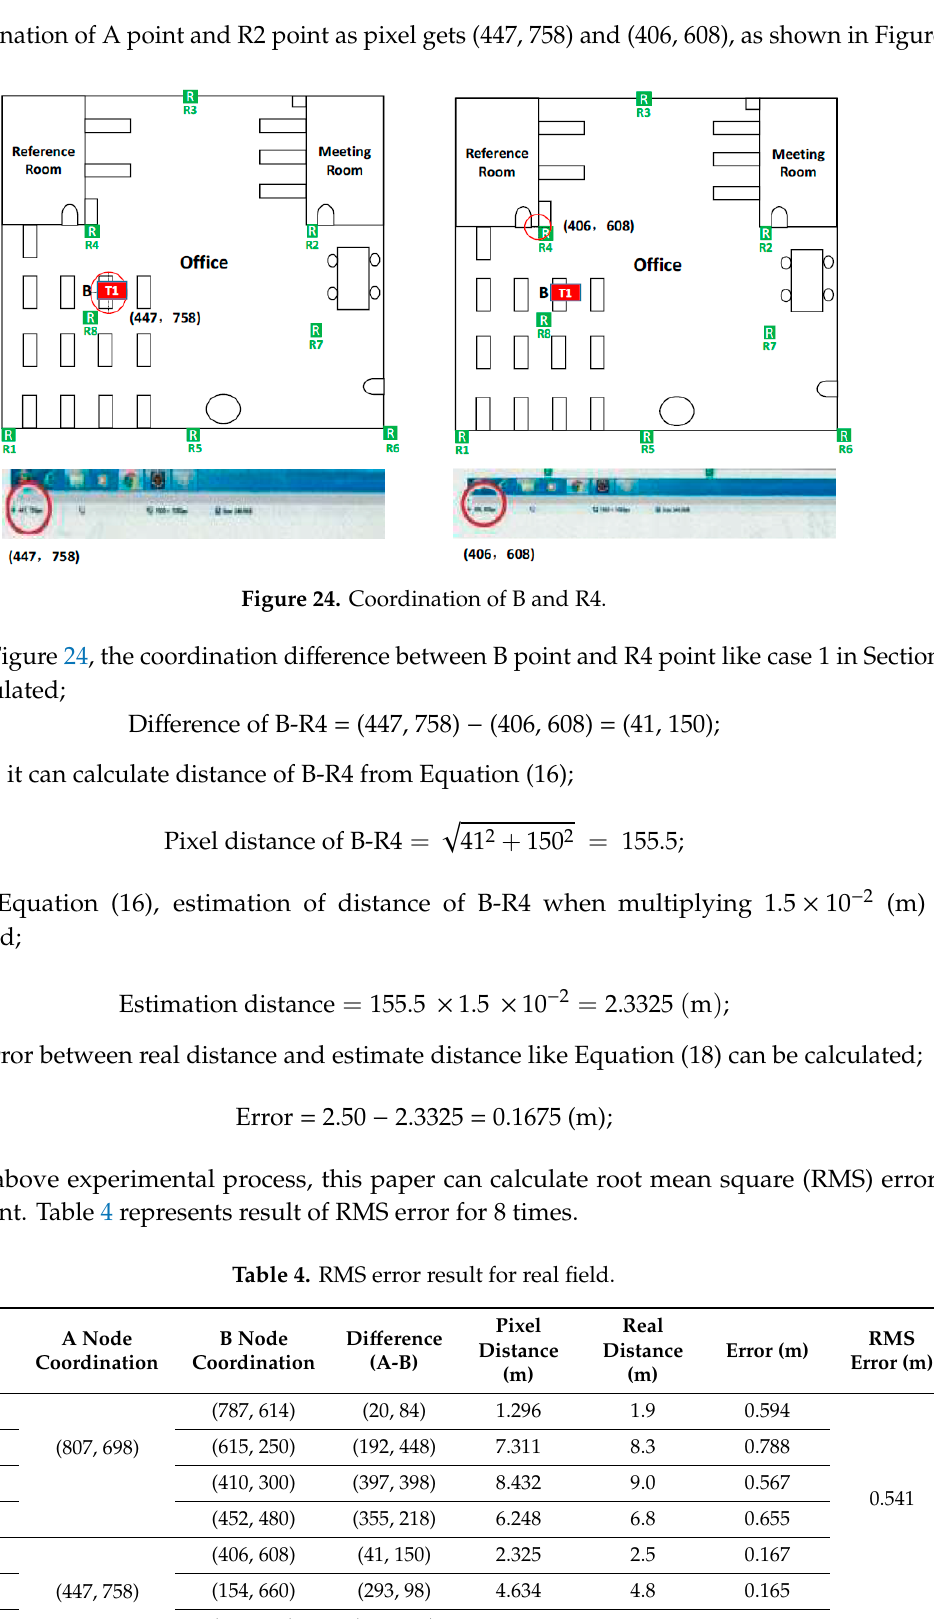
Figure 23. Location B and R4, and real distance between B and R4.